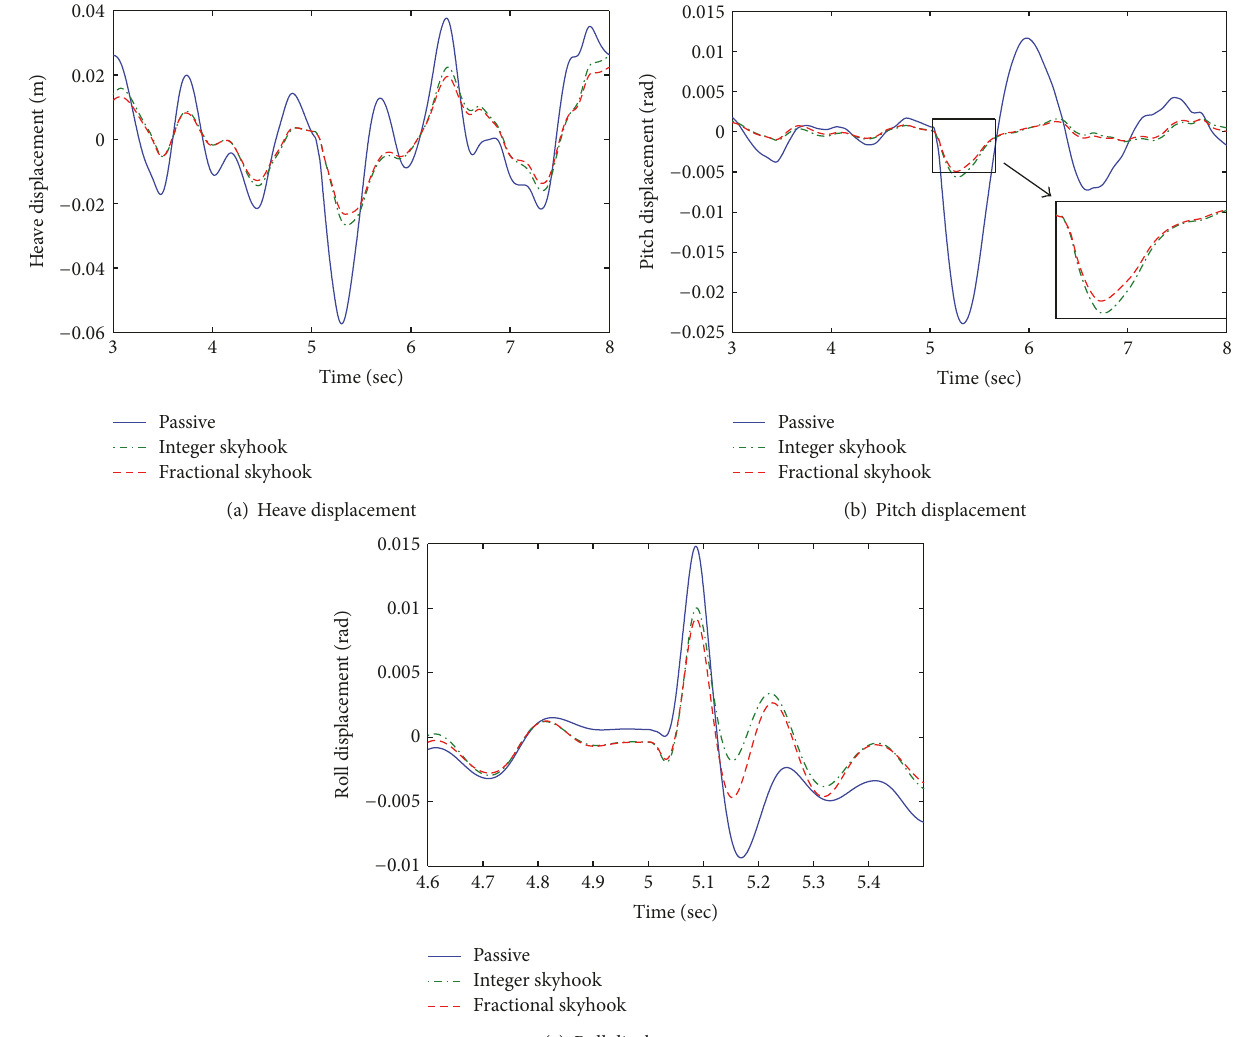
Figure 6: Body motion amplitude response of three kinds of